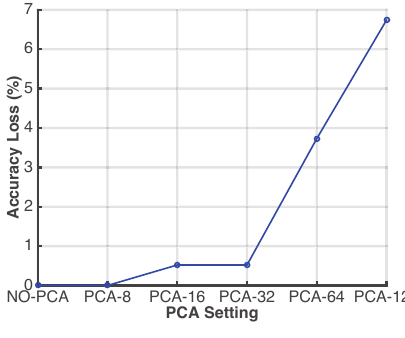
Figure 6. Accuracy Loss with Different PCA Settings